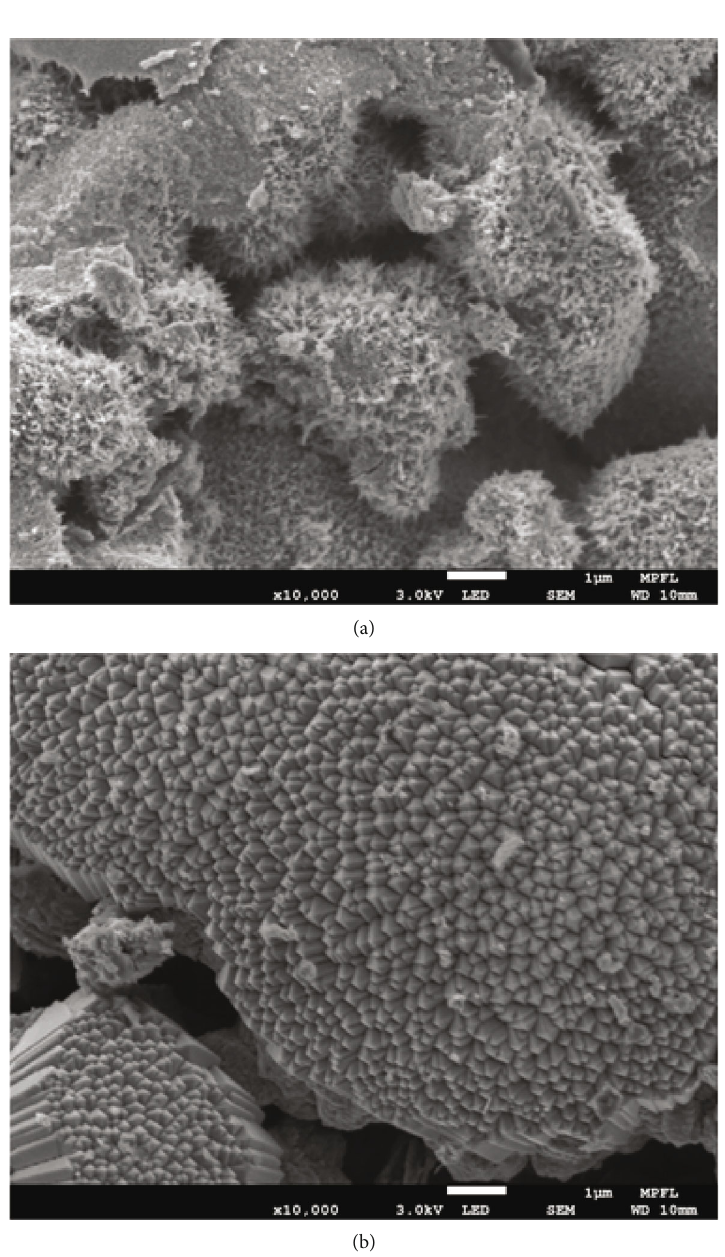
Figure 7: FESEM images of (a) Mn